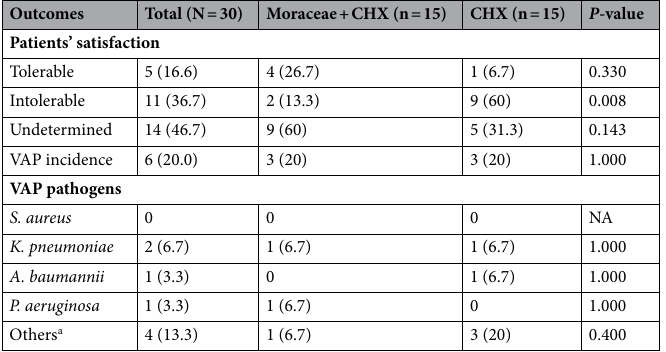
Table 4. Patients’ satisfaction and VAP data between 2 groups. Data are presented as n (%). CHX, chlorhexidine; VAP, ventilator-associated pneumonia. a Other organisms: Stenotrophomonas multophila , n = 3; Candida albicans, n = 1.